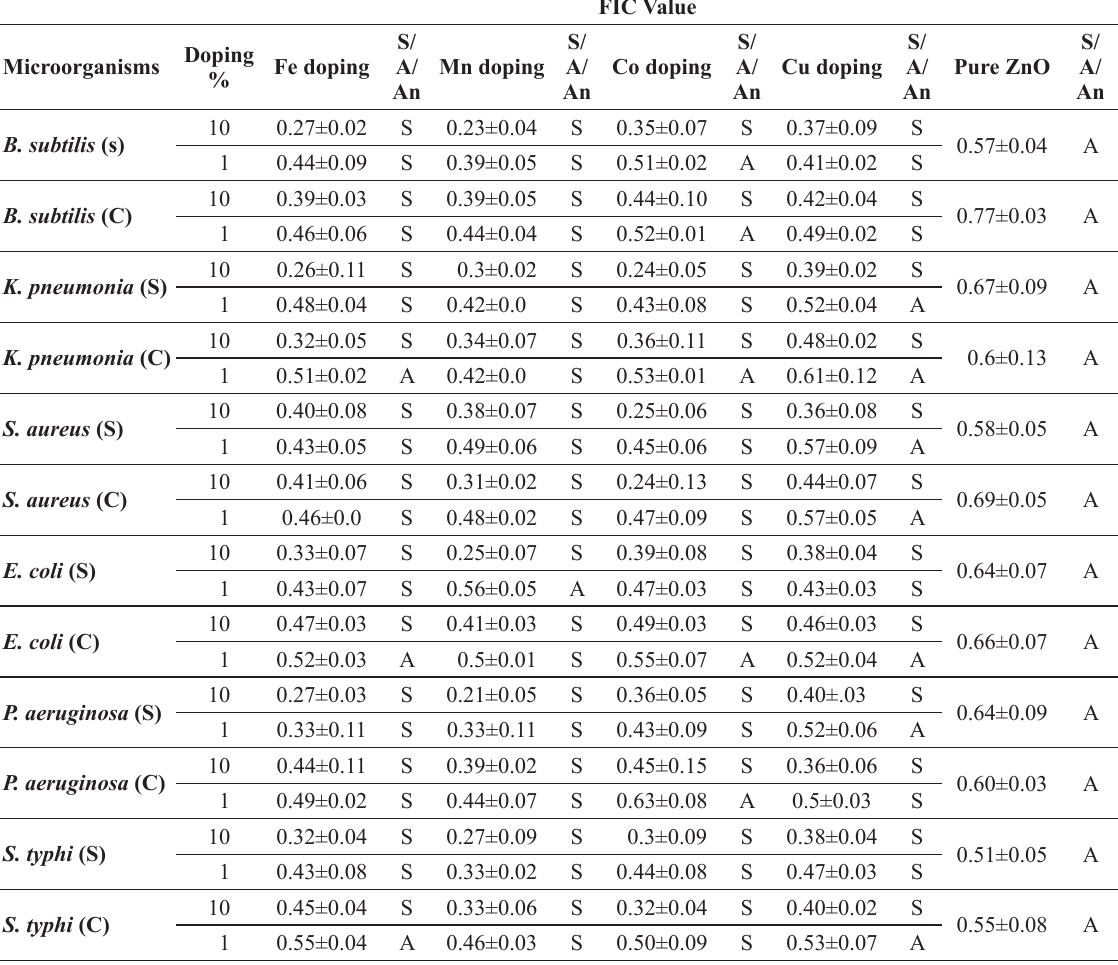
Combined activity of nanoparticles with ampicillin against different pathogenic microorganisms. FIC